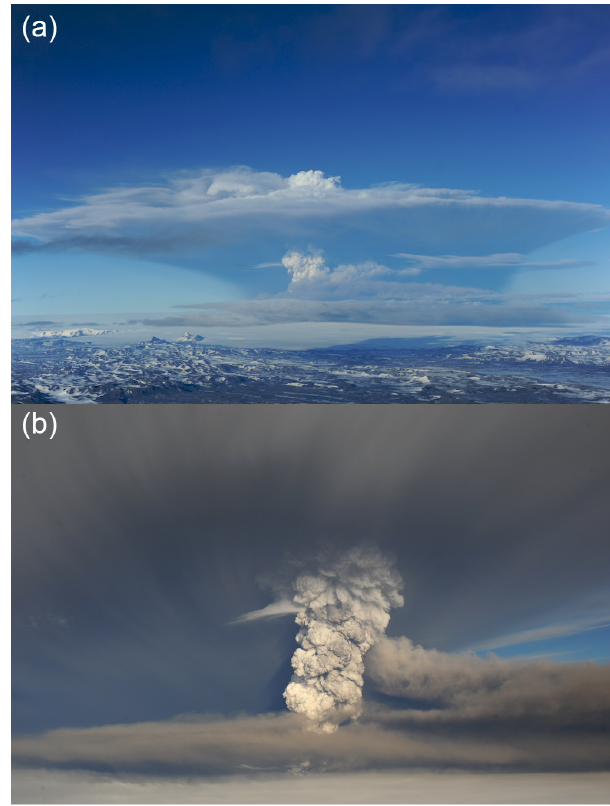
Figure 1. The changing appearance of the Grímsvötn eruption col- umn in photographs taken at the start of the eruption in clear skies at 20:10UTC (20:10 local time) where the whitish appearance of the column suggests condensed water vapour (a) and later (21:05UTC) in a dark (ash-rich), cloud-laden atmosphere (b) . There is a clear in- dication (lower photograph) of ash in the lower parts of the column. Later photographs show mammatus clouds forming in the eruption cloud, suggesting ice nucleation, and this may have contributed to a more rapid loss of ash particles from the cloud. Photographs cour- tesy of Ólafur Sigurjónsson. See also Supplement photographs.